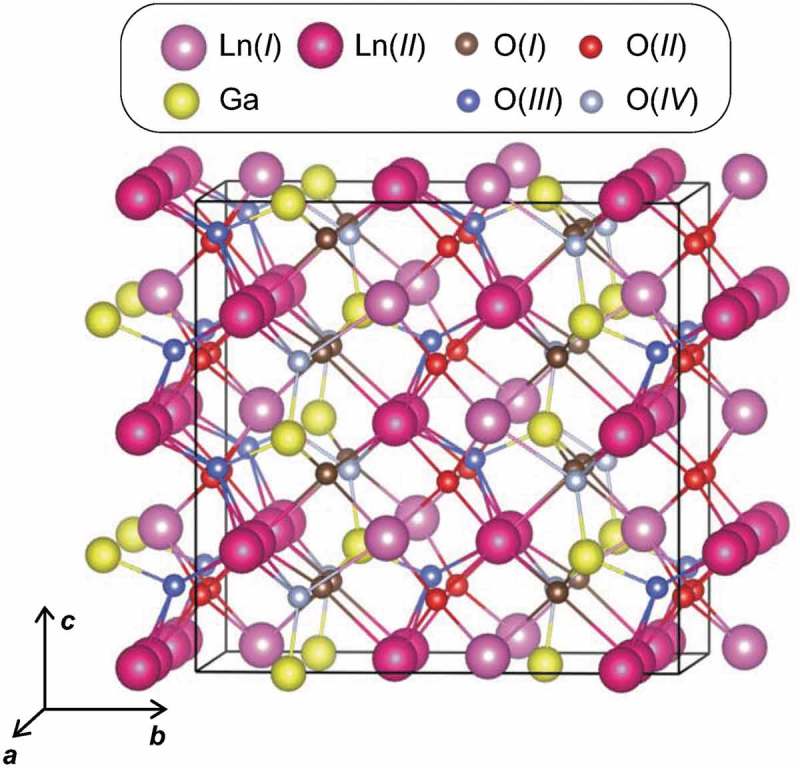
Crystal structure of Ln3GaO6 with space group Cmc21. The supercell (1 × 1 × 2 conventional orthorhombic unit cell) with 24 Ln, 8 Ga, and 48 O atoms is shown. Different types of Ln and O sites are presented by different colors.